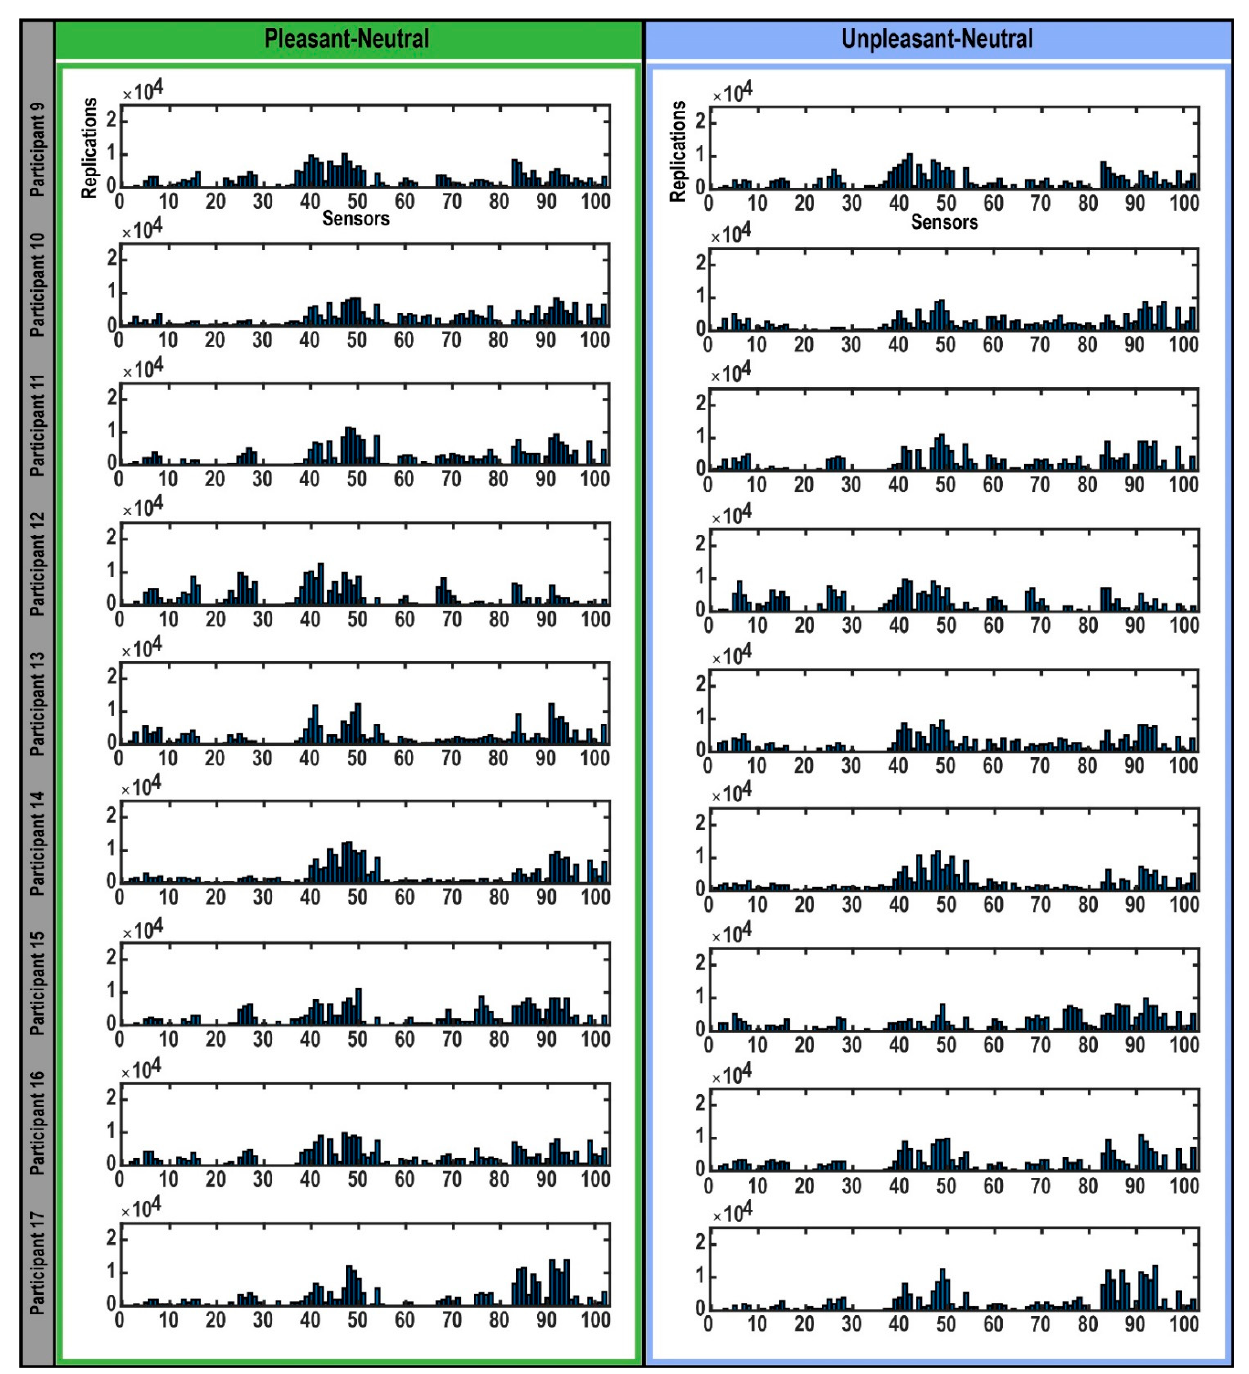
Figure 2. Selection of sensors in bootstrapping replications. The bar plots represent the sensors that expressed the highest differences in each participant’s brain response to highly arousing pleasant ( left ) and unpleasant ( right ) emotional pictures compared to neutral pictures during the M300 time interval detected in each bootstrap replication. The Y-axis indicates the 25,000 bootstrap replications. The X-axis shows the 102 magnetometers encompassing the whole brain.